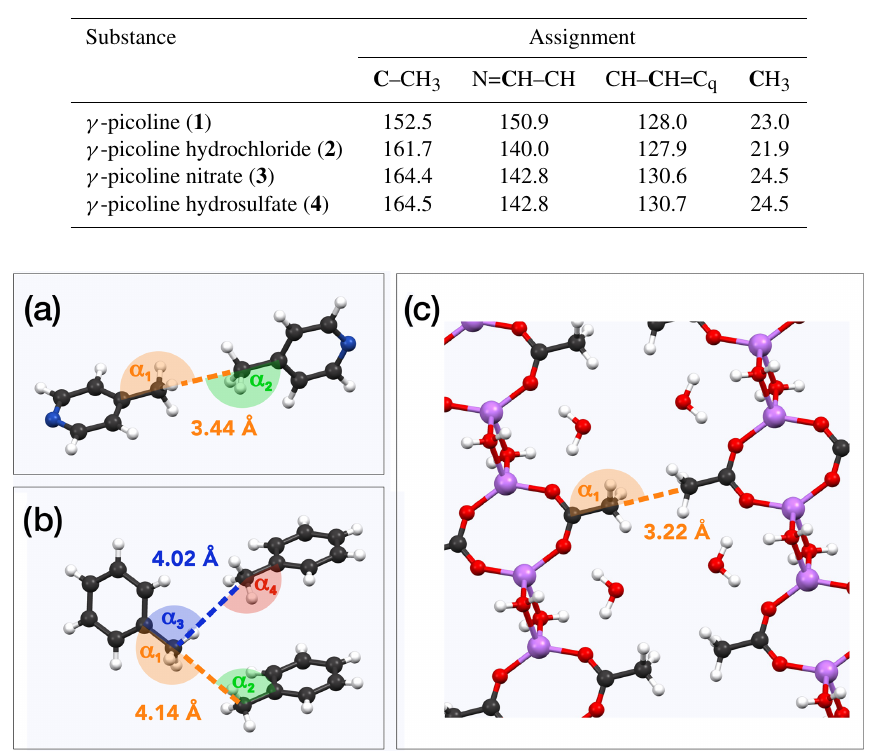
Figure 4. Examples for methyl pairs in the crystal structure. The distance between methyl pairs is given by the carbon-to-carbon distance. Angles are measured along the path from quaternary carbon via methyl carbon to the methyl carbon of the neighbor molecule. (a) γ -picoline ( 1 ) methyl pairs from crystal structure ZZZIVG, angles α 1 and α 2 , vary between 177 and 180 ◦ (Ohms et al., 1985). (b) Toluene ( 5 ) methyl pairs (TOLUEN); the distance between the closest pairs is either 4.02 or 4.14Å. Respective angles are α 1 = 165 ◦ , α 2 = 97 ◦ , α 3 = 94 ◦ , and α 4 = 157 ◦ (van der Putten et al., 1992). (c) Methyl pairs of lithium acetate dihydrate ( 6 ; LIACET); the angle α 1 is 180 ◦ (Galigné et al., 1970). The ionic bonds (Ac − ··· Li + ··· OH 2 ) are plotted the same as regular covalent bonds in order to improve the spatial comprehensibility of the crystal